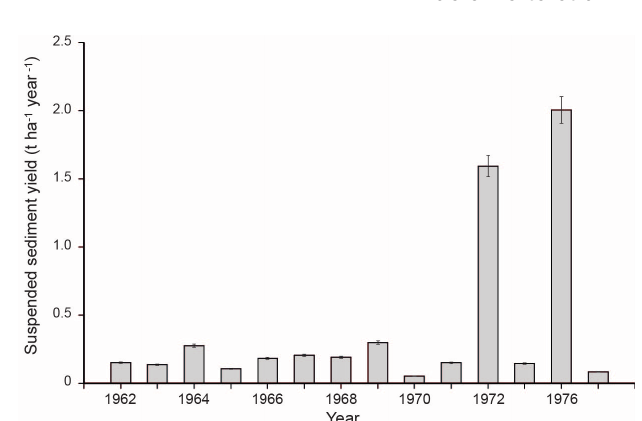
Fig. 2 Annual suspended sediment yields from the Melito